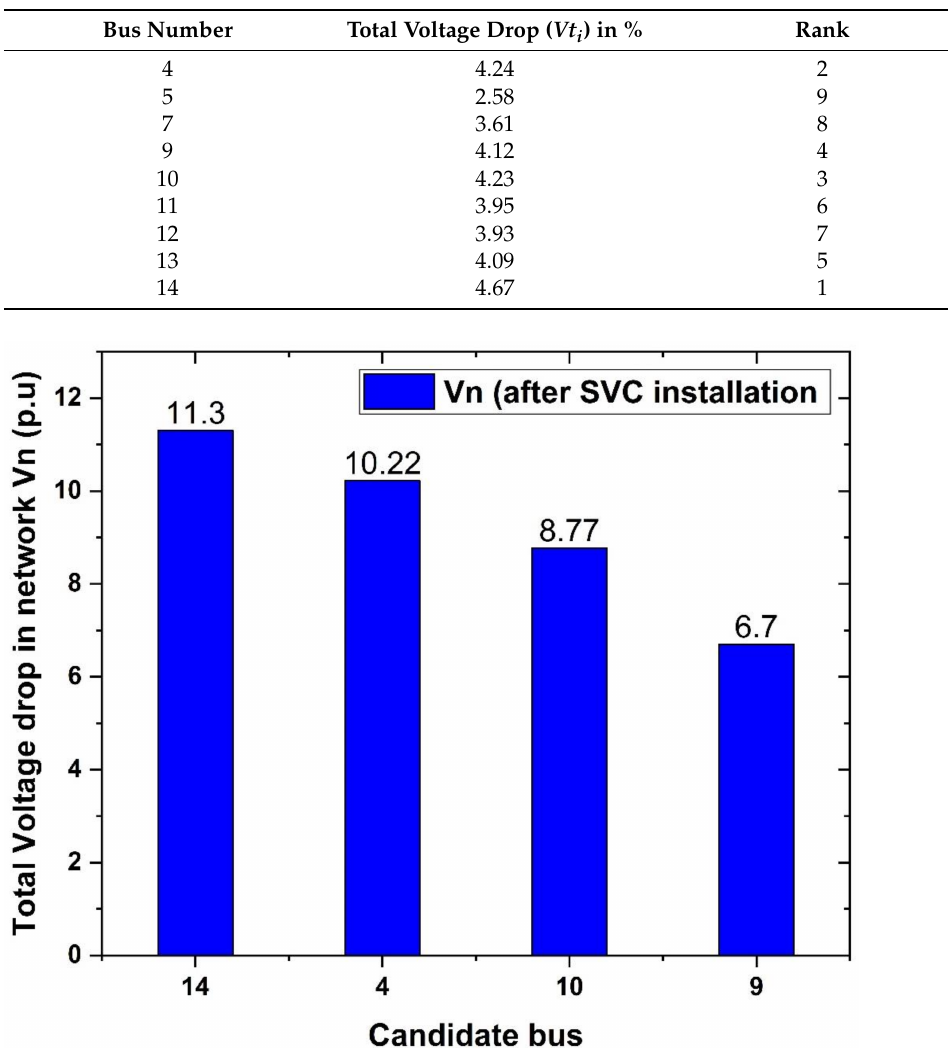
Table 2. Total Voltage drop ( Vt ) and ranking buses.